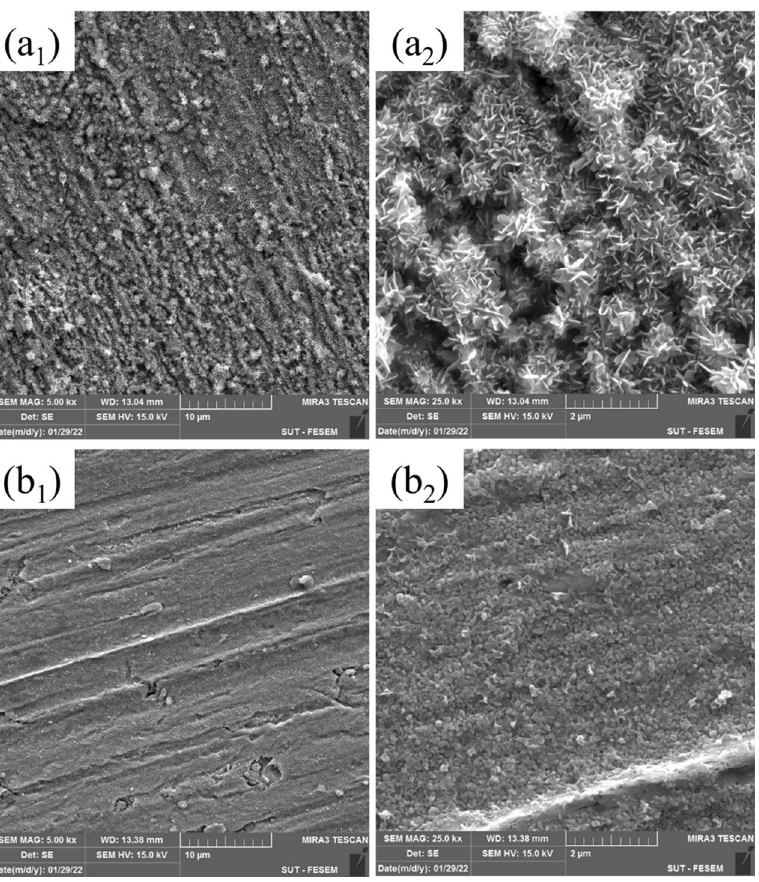
Figure 8. FE-SEM images of MS surface soaked in acidic solution without ( a 1 , a 2 ) and with 800 ppm FV extract ( b 1 , b 2 ).